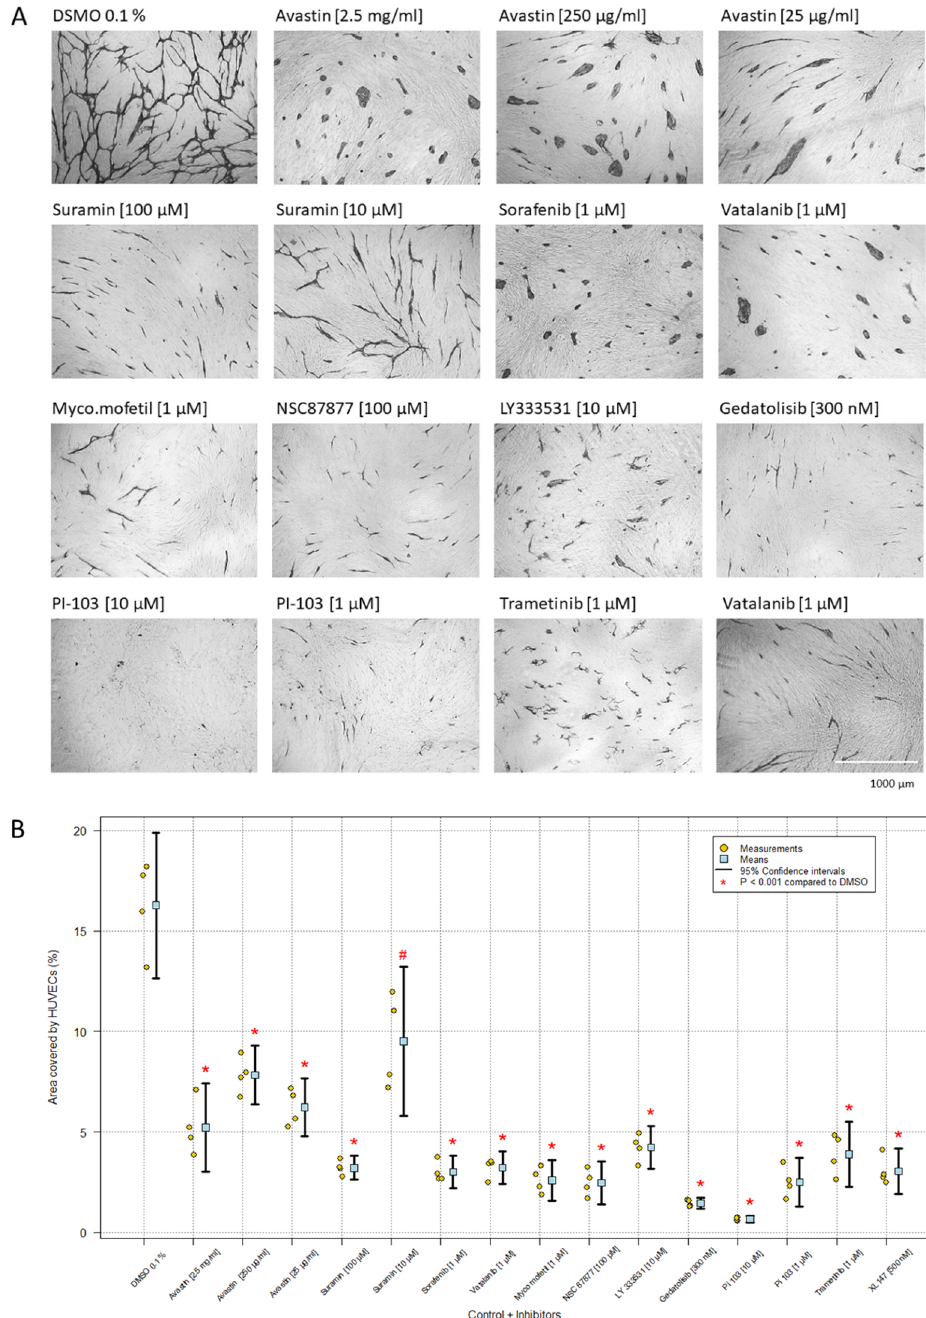
Figure 2. Representative images and image analysis results show the percentage of area covered by HUVECs after treatment with different inhibitors. ( A ) The morphology of the HUVECs was visualized by immunostaining with CD31 MAb. The images are based on one experiment representative of all experiments with these inhibitors (magnification: 4×). The concentrations of the inhibitors were chosen by the lowest concentration that gives a clear visual effect on the morphology without showing the general toxicity. ( B ) Data are illustrated in the plot as the mean of four independent experiments with duplicates and 95% confidence intervals. One-way ANOVA. F = 51.63 and P < 0.001. All treatments differed significantly from the control, except for suramin 10 µM (adjusted * p -values < 0.001, except # p = 0.028).